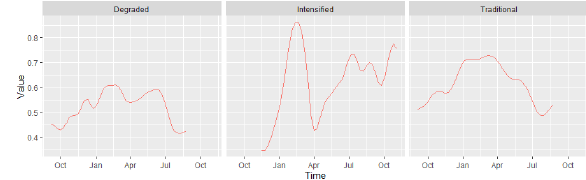
Figure 3. Temporal NDVI patterns of the three pasture managements described in Table 1 and used to classify the pasture areas of the study region